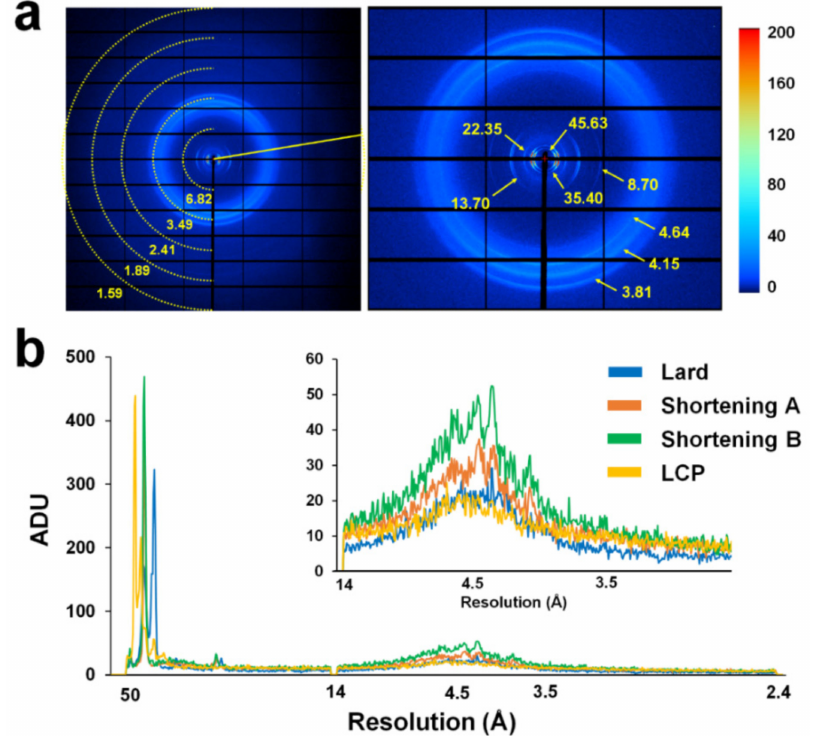
Figure 4. Measurement of X-ray background scattering of lard. ( a ) Typical scattering image of 80% ( w / v ) lard. ( b ) Two-dimensional profile of the average scattering intensities of 80% ( w / v ) lard, 80% ( w / v ) shortening A, 80% ( w / v ) shortening B, and lipidic cubic phases (LCP) (60% ( v / v ) monoolein). Background scattering from lard showed 172, 323, 24, 26, 16, and 15–30 analog-to-digital units (ADUs) at 45.63, 35.40, 22.35, 13.70, 8.70, and 3.5–5.0 Å areas, respectively (Figure 4a). The